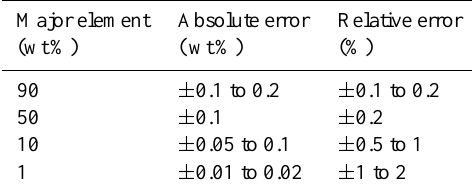
Table A2. Absolute and relative error for the whole-rock chemical